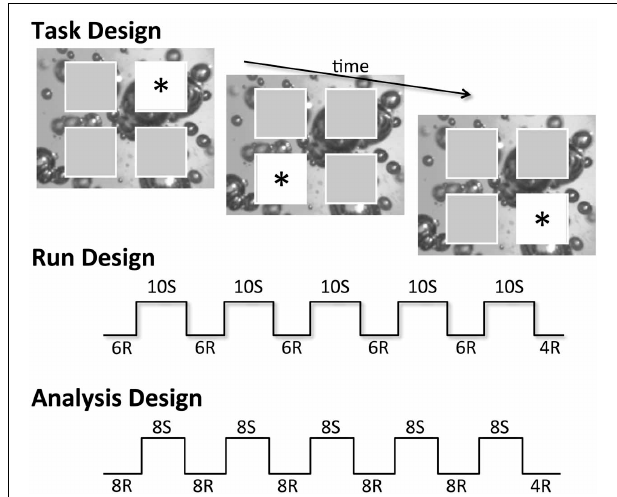
FIGURE 1 | Basic task, run, and analysis design used for each of the five runs of the SRT task variants, where R represents pseudorandomly appearing stimuli and S denotes stimuli that followed the 10-item spatial sequence. Stimuli are denoted by an asterisk; actual stimuli used were cartoon characters from the children’s television program Sesame